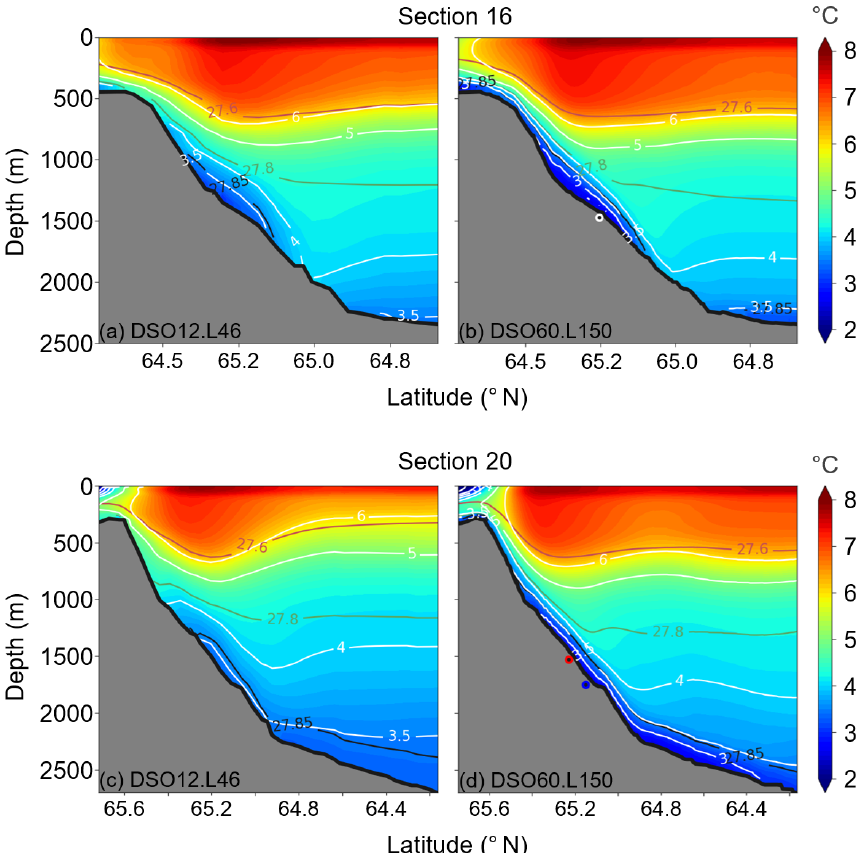
Figure 6. Distribution with depth of the annual mean temperature (fifth year of model run) at section 16 (Dohrn Bank array) for (a) simulation DSO12.L46 and (b) simulation DSO60.L150 (in the refined grid), as well as at section 20 (Spill Jet section) for (c) simulation DSO12.L46 and (d) simulation DSO60.L150 (in the refined grid). Temperature ( ◦ C) is represented by colours with white contours. Potential density values ( σ 0 ) are shown by the contour lines coloured in red (27.6), green (27.8), and black (27.85). The white-rimmed dot in (b) corresponds to the location of the profiles displayed in Fig. 15, and the red-rimmed and blue-rimmed dots in (d) correspond to the locations of the profiles displayed in Fig.